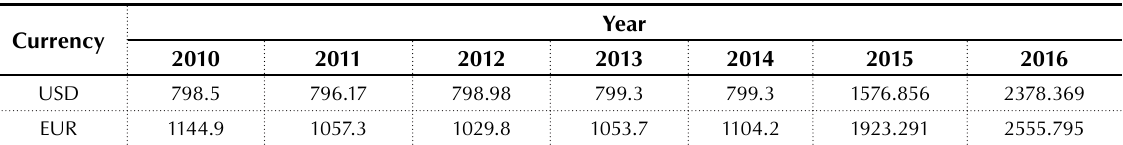
Source: Internet site of the National Bank of Ukraine (2016).